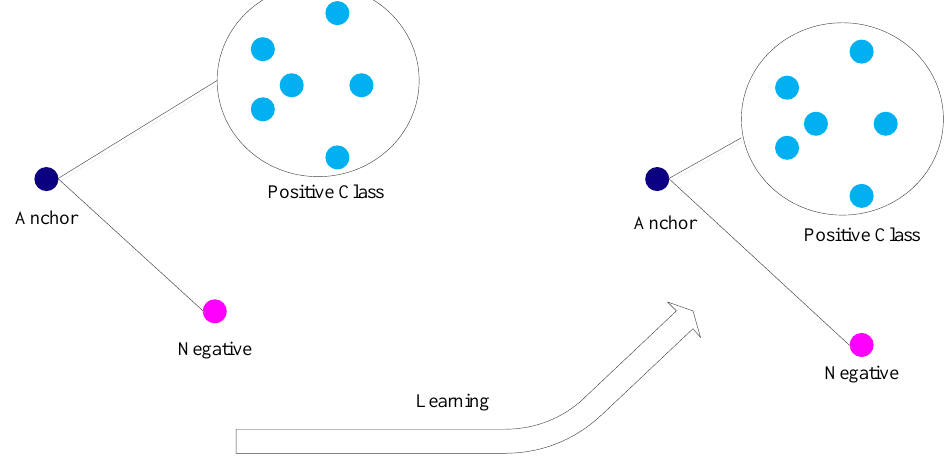
Figure 2. Illustration of the new triplet loss with sample to class